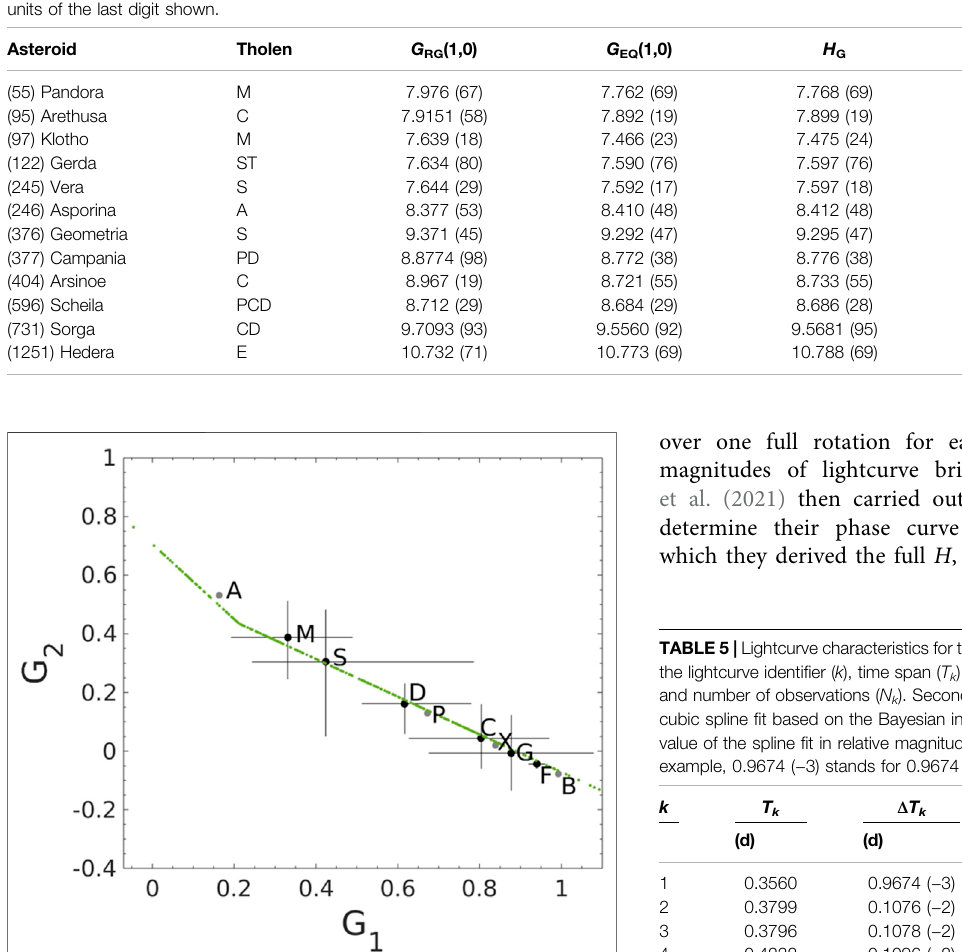
FIGURE 8 | The distributions of the different Tholen classes (black dots) and their range (black crosses) in the G 1 and G 2 parameter space based on the equal-sphere phase functions. The grey dots represent single asteroids and thegreenlineshowshowthe G 12 parametermaps into G 1 and G 2 in the H , G 12 magnitude system.